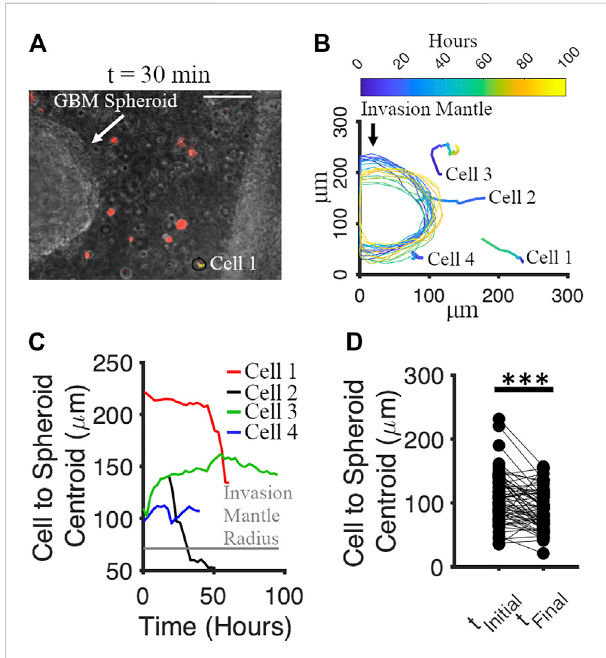
FIGURE 9 Motion of cortical cells relative to the GBM spheroid in Matrigel. (A) Phase micrograph ofa GBMspheroid embedded in Matrigel matrix with cortical cells (labeled by Dil, red) at t = 30 min. Scale bar: 70 μ m. (B) Tracking of cortical cells and invasion mantle of GBM spheroidovertime.ColorscorrespondtodifferenttimesafterMatrigel embedding. (C) Distances from 4 representative cortical cells to the invasion mantle ’ s centroid of a GBM spheroid over time. (D) Distances from cortical cells to the invasion mantle ’ s centroid of GBM spheroid at the initial and the fi nal time. Two-sample paired t -test was used to measure the statistical signi fi cance. N = 64 cortical cells. *** p < 10 – 4